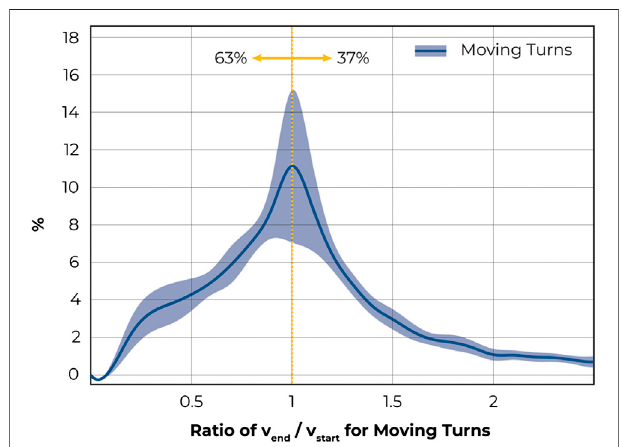
FIGURE 6 | Graph showing ratio between initial and fi nal velocity of moving turns. Only moving turns where the wheelchair was considered to be movingbeforeandaftertheturnwereincluded.Aratiogreaterthan1indicates an increase in velocity over the course of the turn. 63% of turns were associated with a decrease in velocity.